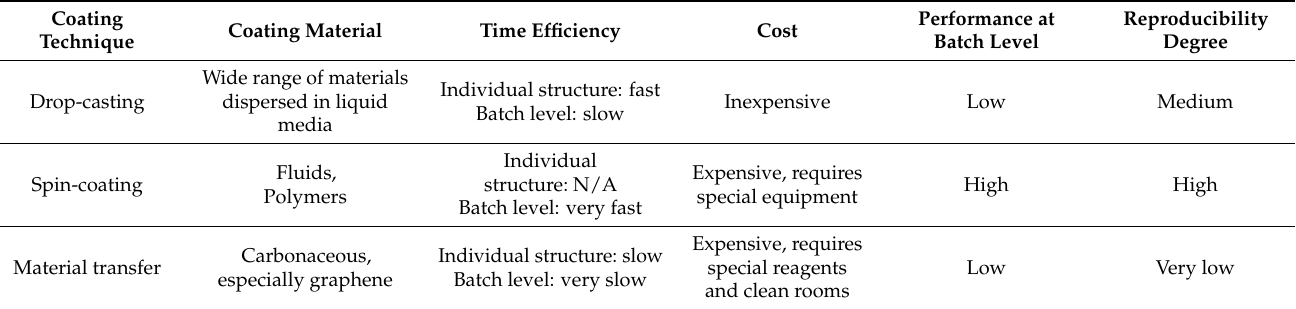
Table 1. Comparison of coating techniques for the development of gas-SAW